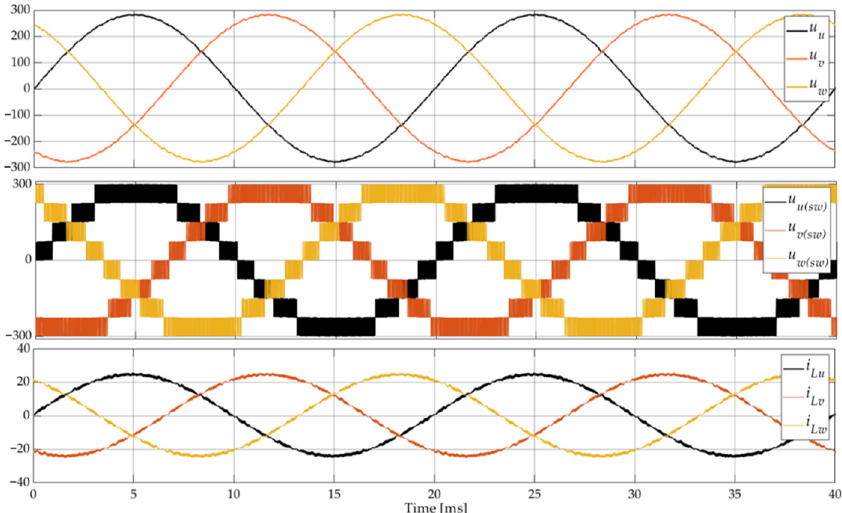
Figure 15. Waveforms of the 3 Φ 5L E-Type MMI, from top to bottom: output phase voltages u u , u v , u w , phase-to-neutral switching voltages u u(sw) , u u(sw) , u u(sw) , inductor phase currents i Lu , i Lv , i Lw .